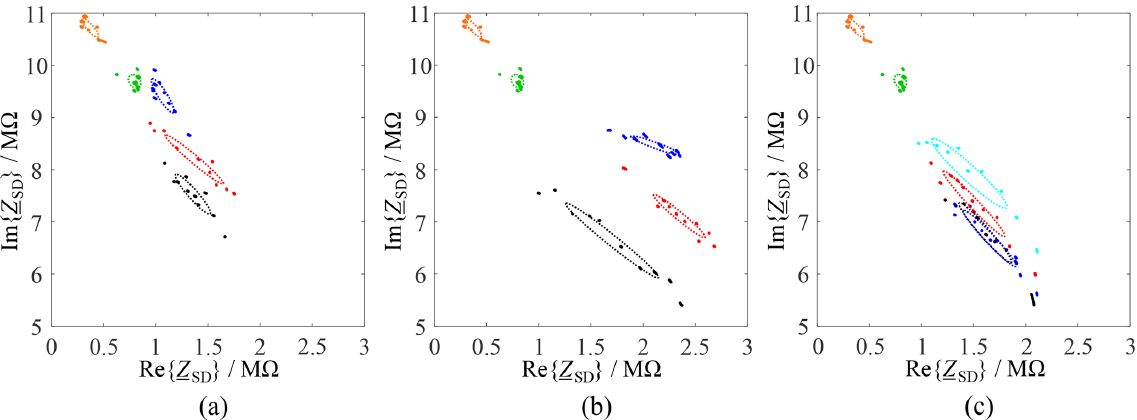
Figure 9. Distribution of the “standard deviation” feature for repeated measurements of various MUTs. Color coding as in Fig. 6. (a) MUT 1a and b and MUT 2a to c. (b) MUT 1a and b and MUT 3a to c. (c) MUT 1a and b and MUT 4a to